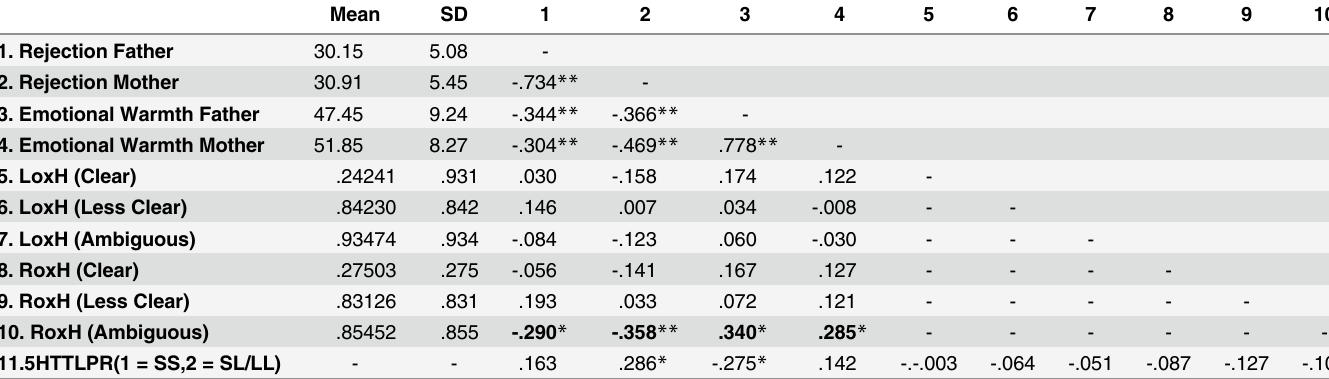
Table 2. Variables assessed in the present study: Means, standard deviations, and correlations between the